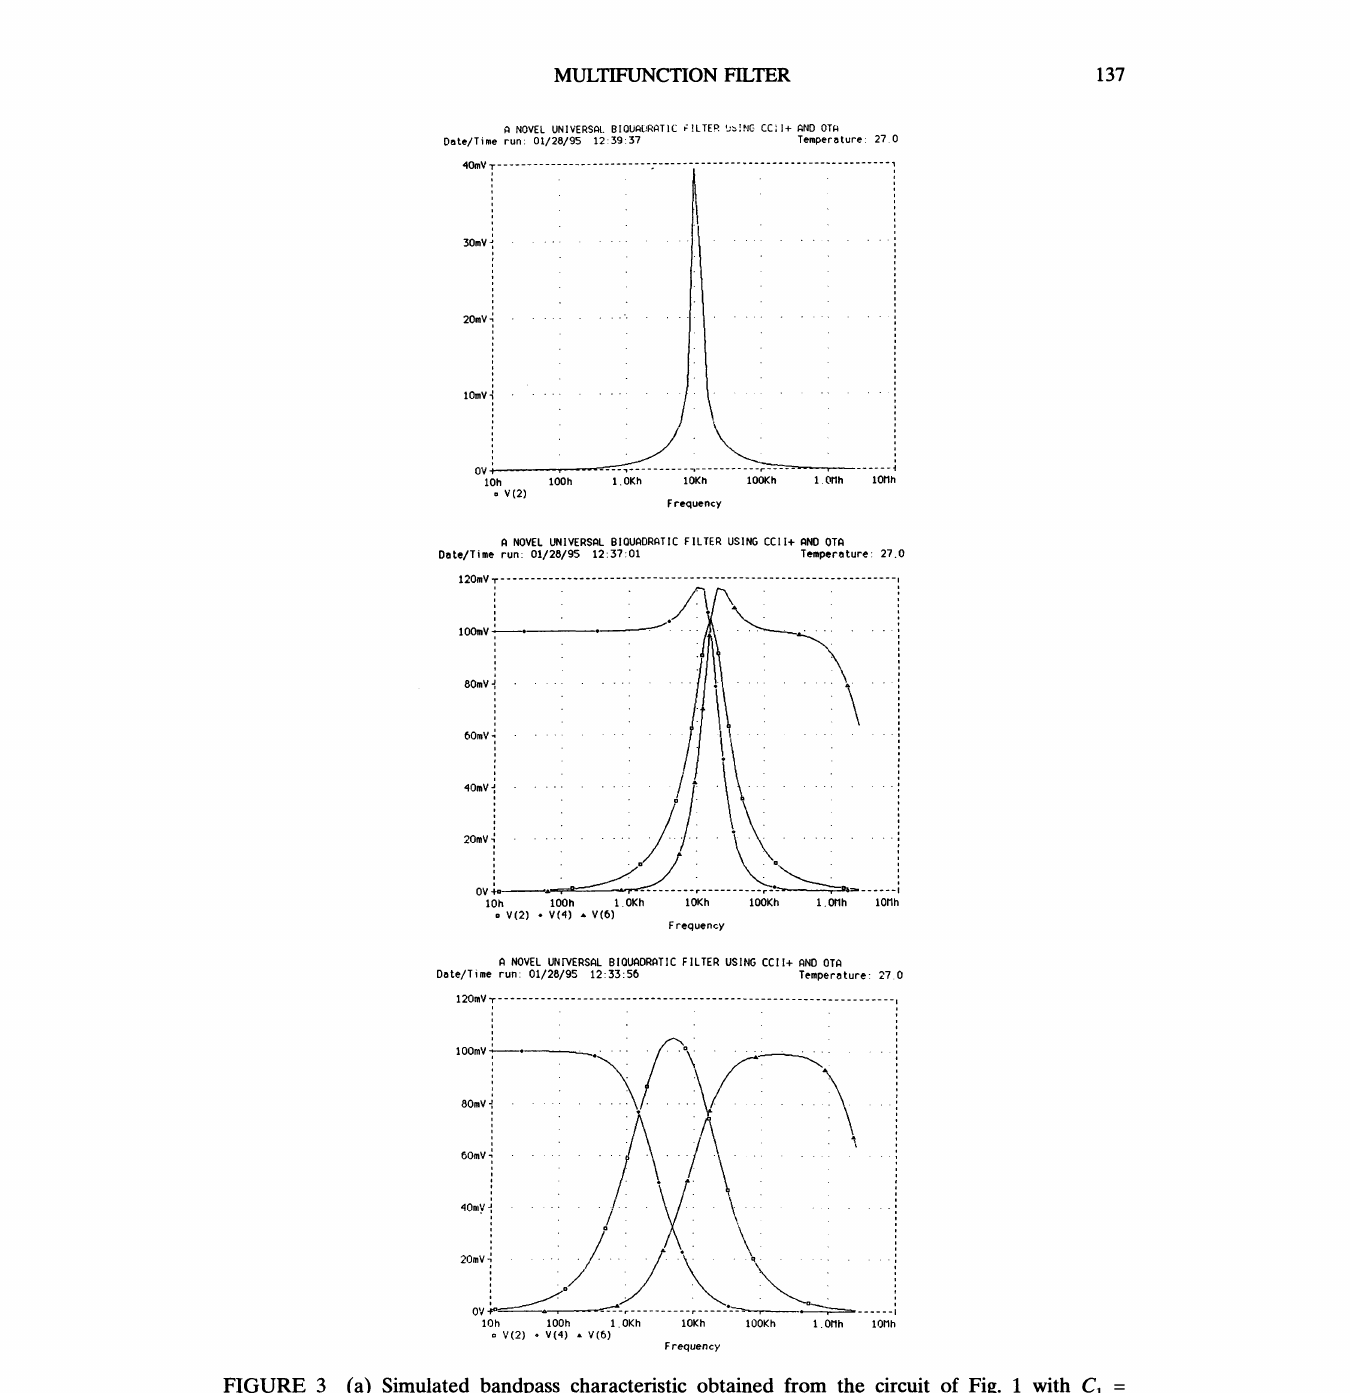
FIGURE 3 (a) Simulated bandpass characteristic obtained from the circuit of Fig. 1 with C1 1.OF,C: 1.OnF,